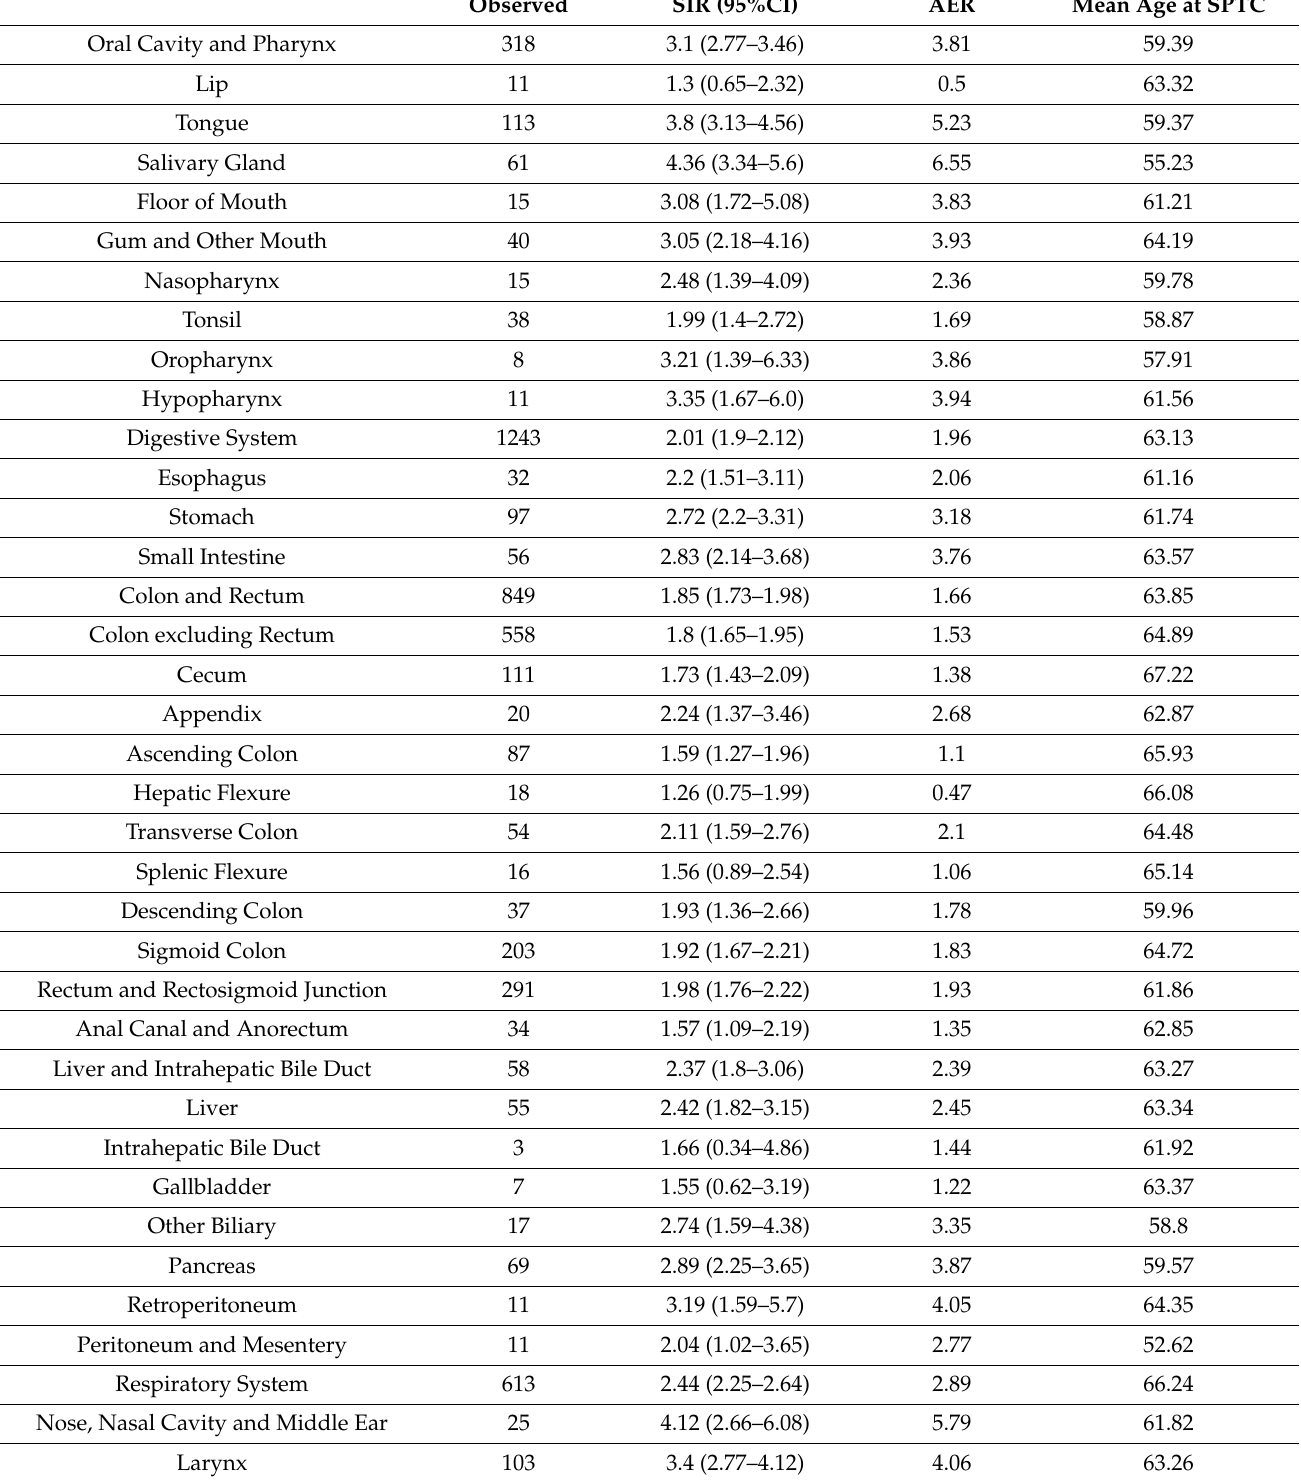
Table 1. Standardized Incidence Ratios for SPTC stratified by the site of primary cancer.